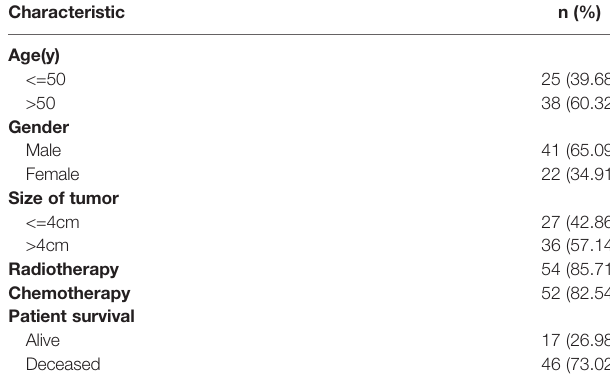
TABLE 1 | Clinicopathologic characteristics of 63 patients with